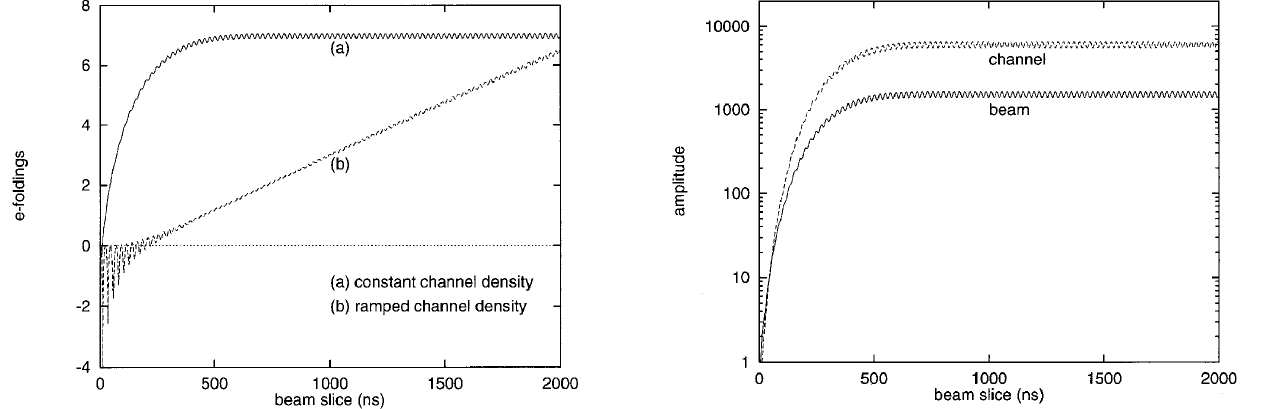
FIG. 3. Amplitudes of channel and beam displacements at the end of the accelerator from numerical integration of linear model